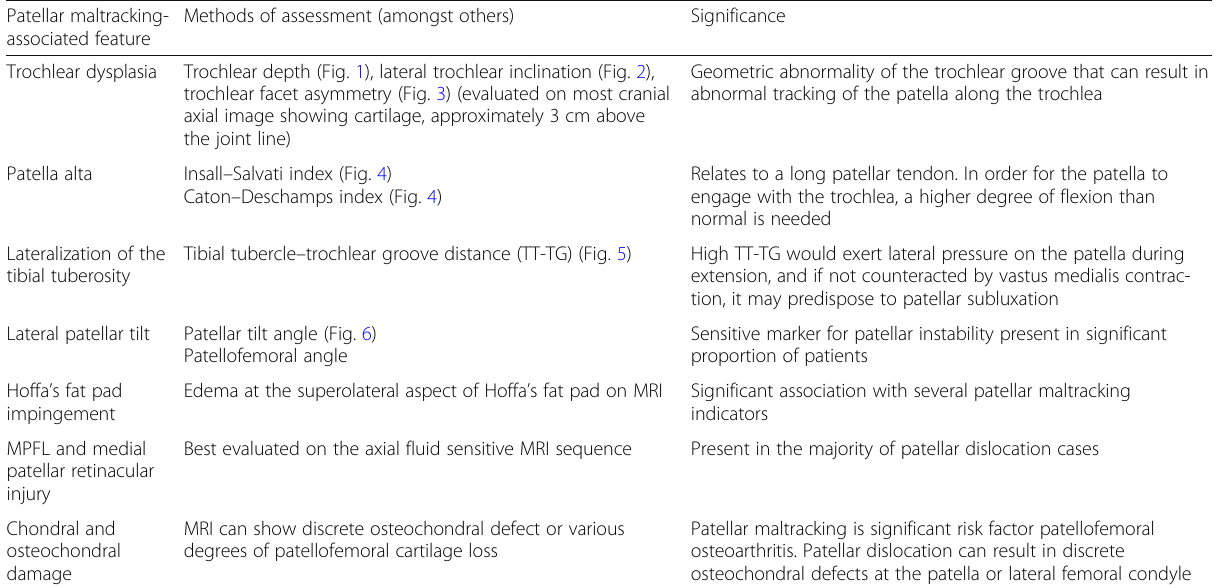
Table 1 MRI checklist for the assessment of patellar maltracking Patellar maltracking- Methods of assessment (amongst associated feature